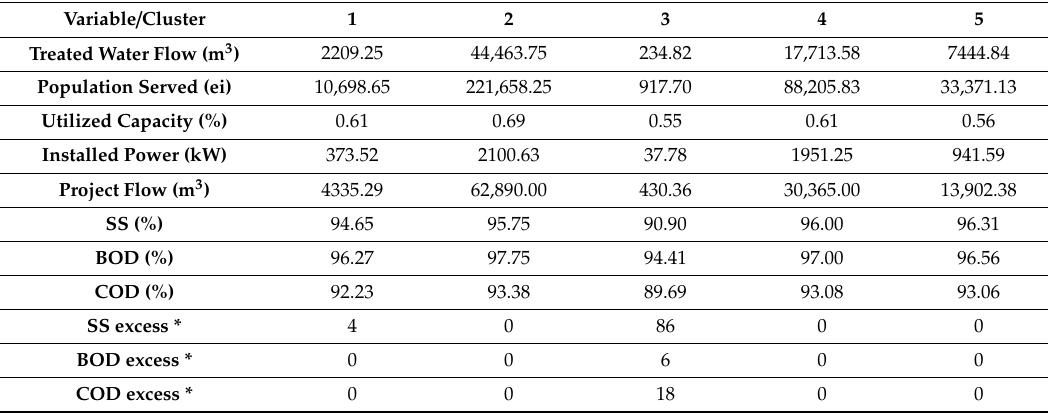
Table 3. Means of Cluster Analysis Variables